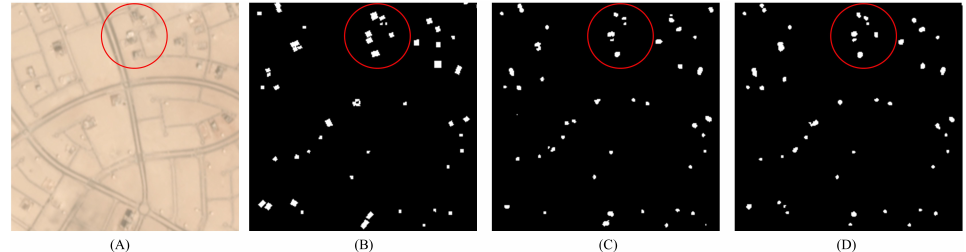
Figure 10. Example of the poor extraction result. ( A ) Image. ( B ) The ground truth. ( C ) CBR-Net. ( D ) SGFANet. A distinct area of inadequate extraction is highlighted by a red